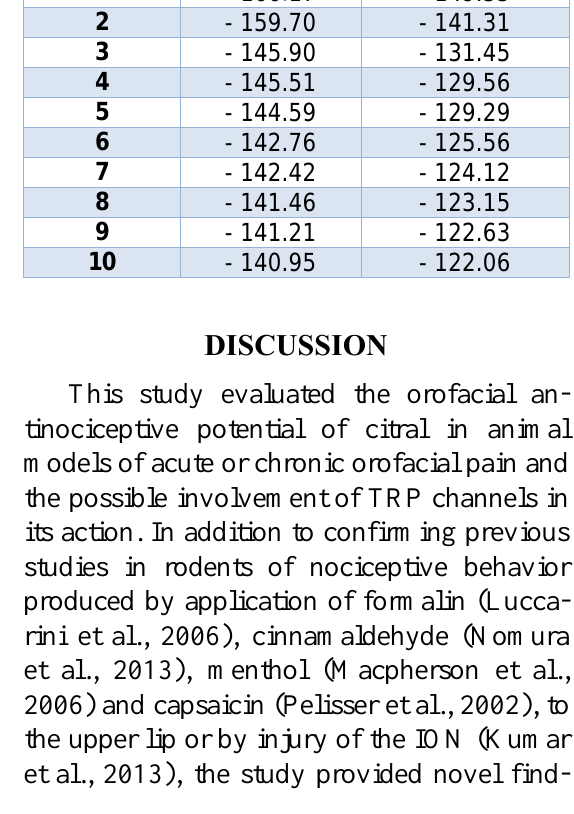
Table 4: Binding energies between citral isomers and TRPM8 channel (E total – Kcal/mol) Cluster of